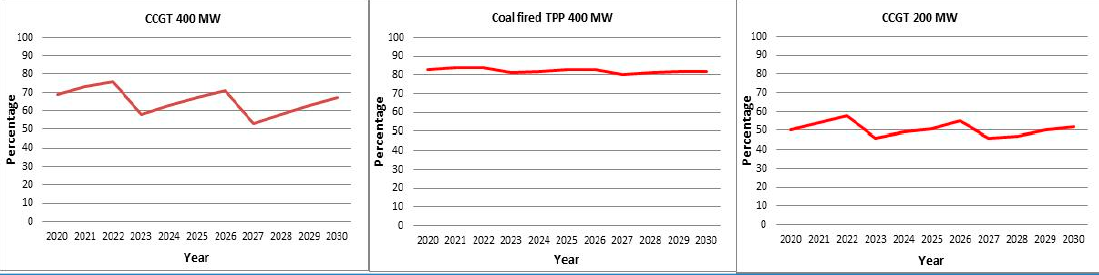
Figure 11. Load factor of new power plants in the LCP scenario and VOLL $2 USD/kWh.